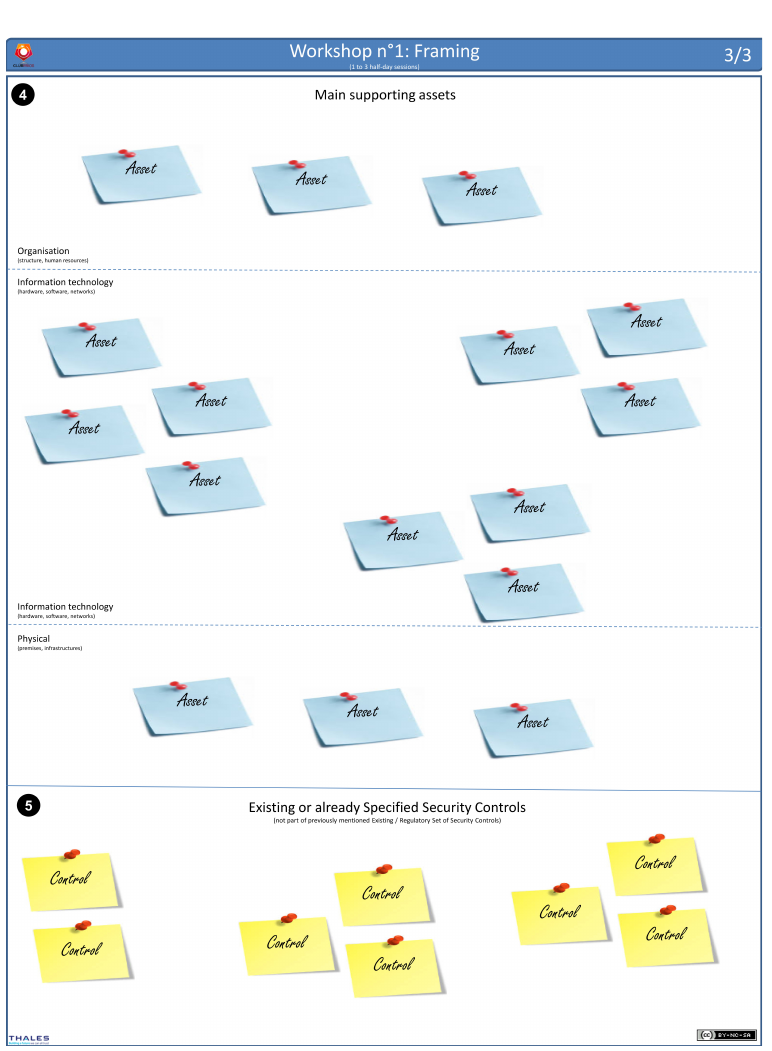
Figure 6. Ob é risk datasheet—workshop n ◦ 1: framing and security baseline, part 3 of